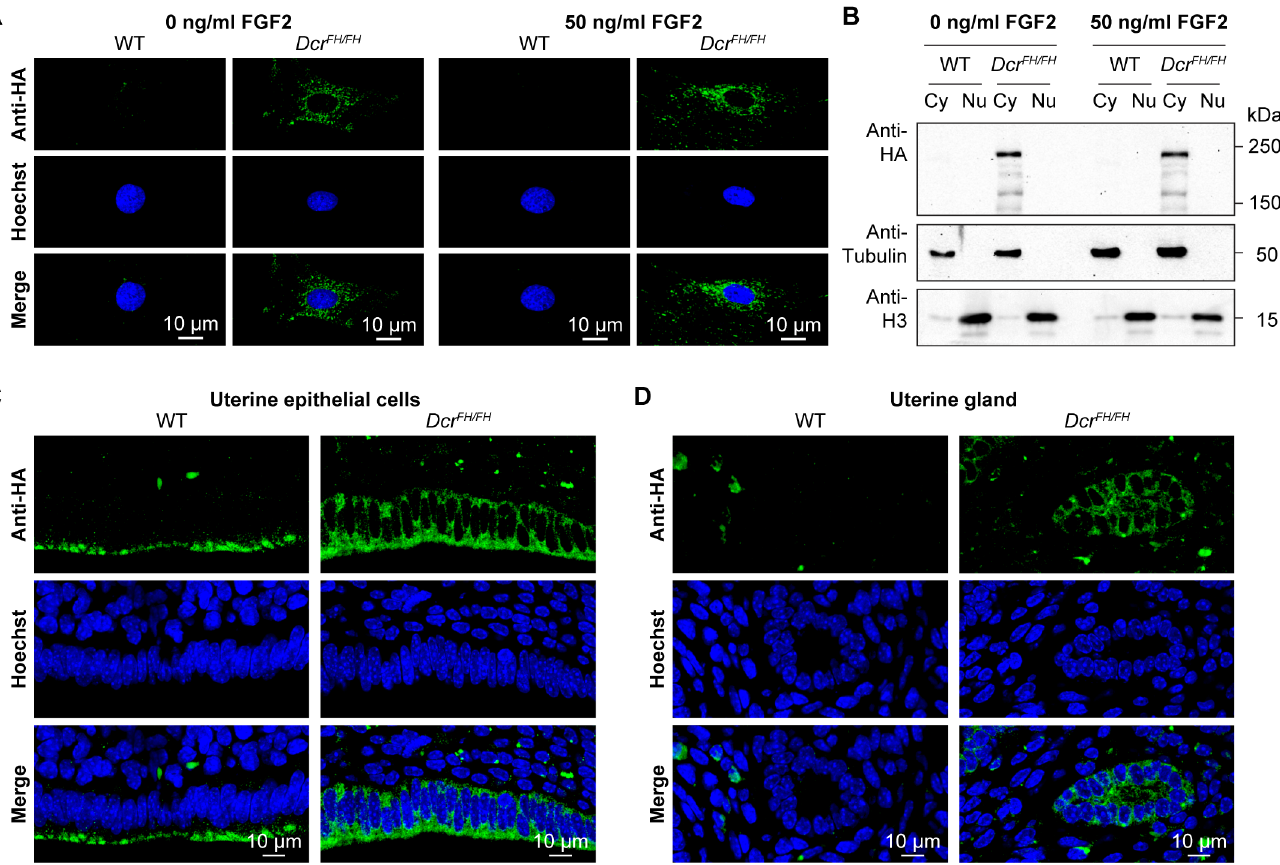
Fig 3. FGF signaling does not induce translocation of Dicer to the nucleus. (A) Confocal micrographs showing immunofluorescence anti-HA staining of wild type and Dcr FH/FH serum starved PMEFs after stimulation with FGF2. Nuclei are stained with Hoechst. Scale bars represent 10 μ m. (B) Western blot analysis after FGF2 stimulation and subcellular fractionation. Anti-HA antibody was used on cytoplasmic (Cy) and nuclear (Nu) extracts of treated and untreated cells. Tubulin is a cytoplasmic marker and histone H3 a nuclear marker. (C and D) Anti-HA immunofluorescence of wild type and Dcr FH/FH uterus sections showing epithelial cells lining the lumen (C) and uterine glands